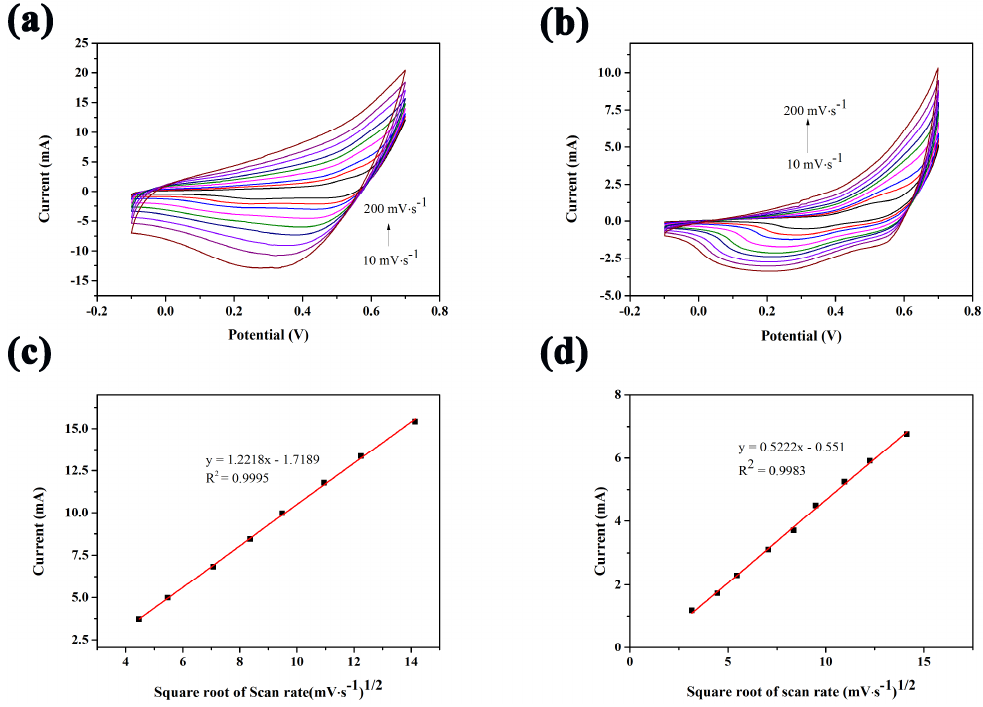
Figure 4. CV curves of ( a ) CuCo 2 O 4 nanosheets on Cu foam and ( b ) bare Cu foam electrodes measured in a 0.1 M NaOH at various scan rates (10–200 mV·s −1 ). ( c , d ) Corresponding plots of current vs. the square root of scan rate for CuCo 2 O 4 /Cu foam and bare Cu foam, respectively.